Question: Write a caption explaining this figure to a reader.
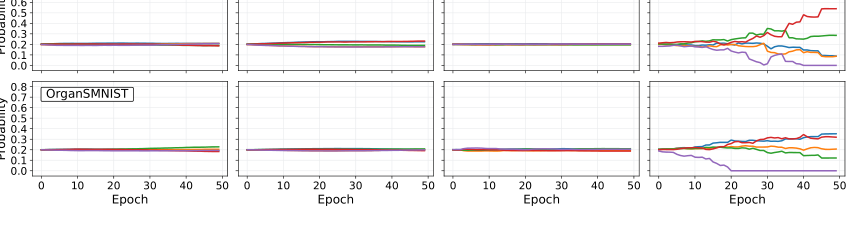
Answer: Probability rank variation of one edge during the search procedure.